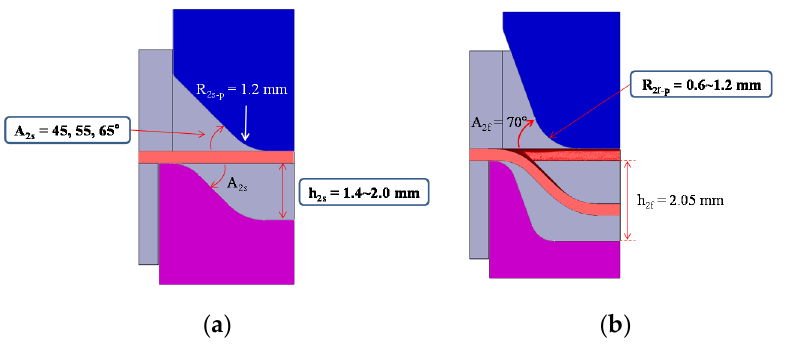
Figure 11. Design parameters of two-stage forming process: ( a ) slitting-preforming and ( b ) final forming.